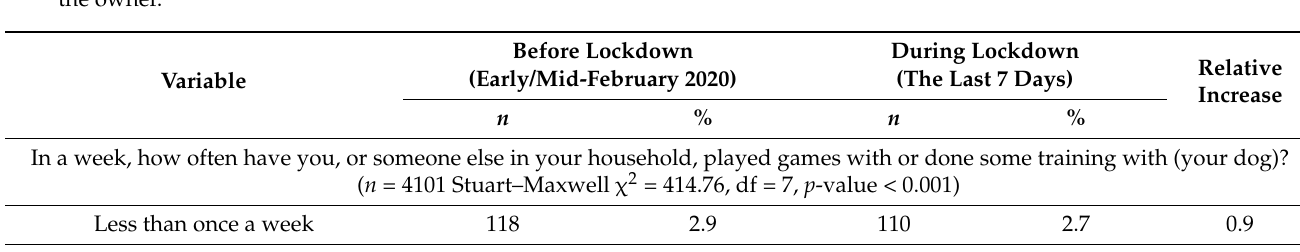
Table 8. Frequency with which dogs were given a toy to play with, played games with or participated in training with the